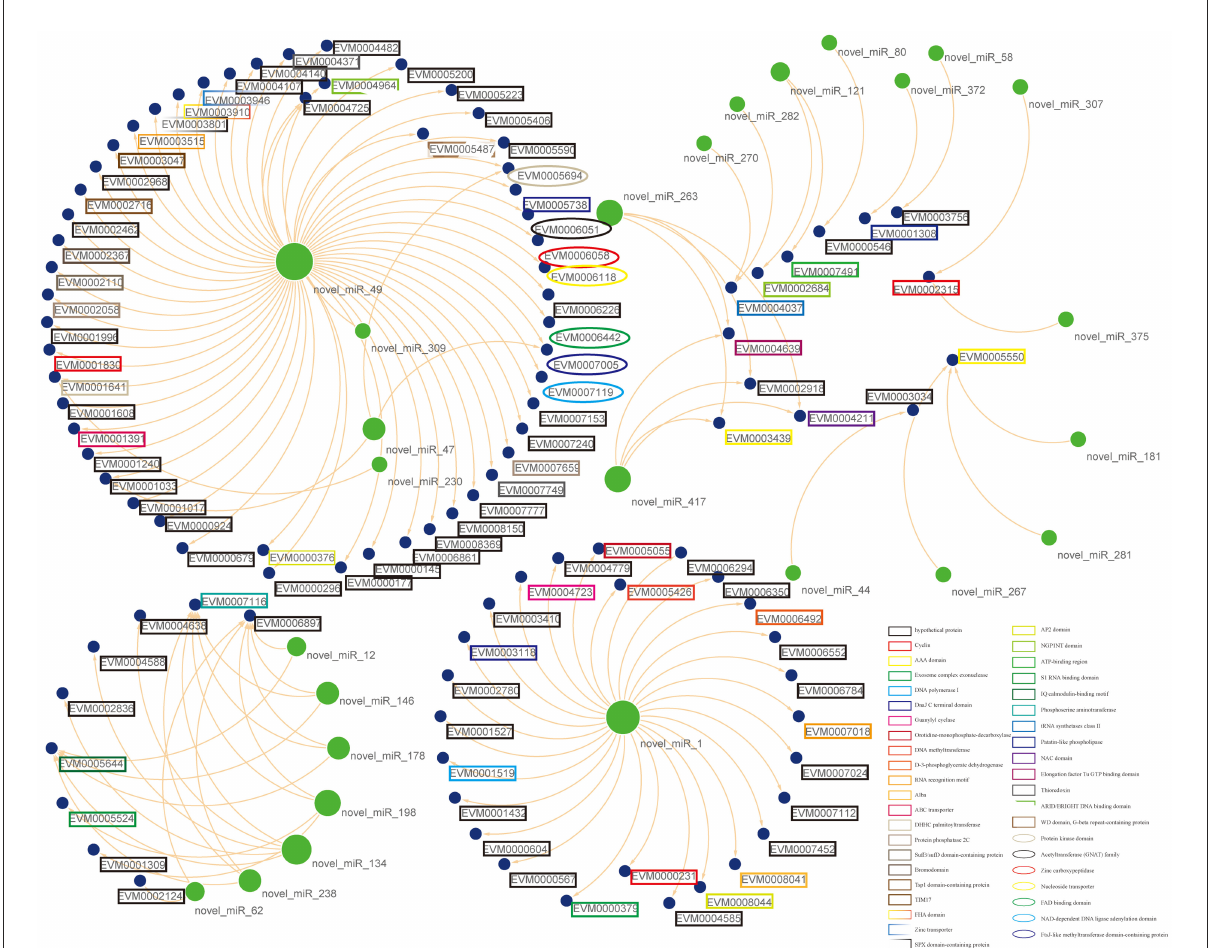
FIGURE5 Putative functional interactions. All the co-expressed interactions found in this study are shown as a network by using Cytoscape. The size of the node represents its outdegree, and the functional annotations for mRNAs were also marked in the lable.